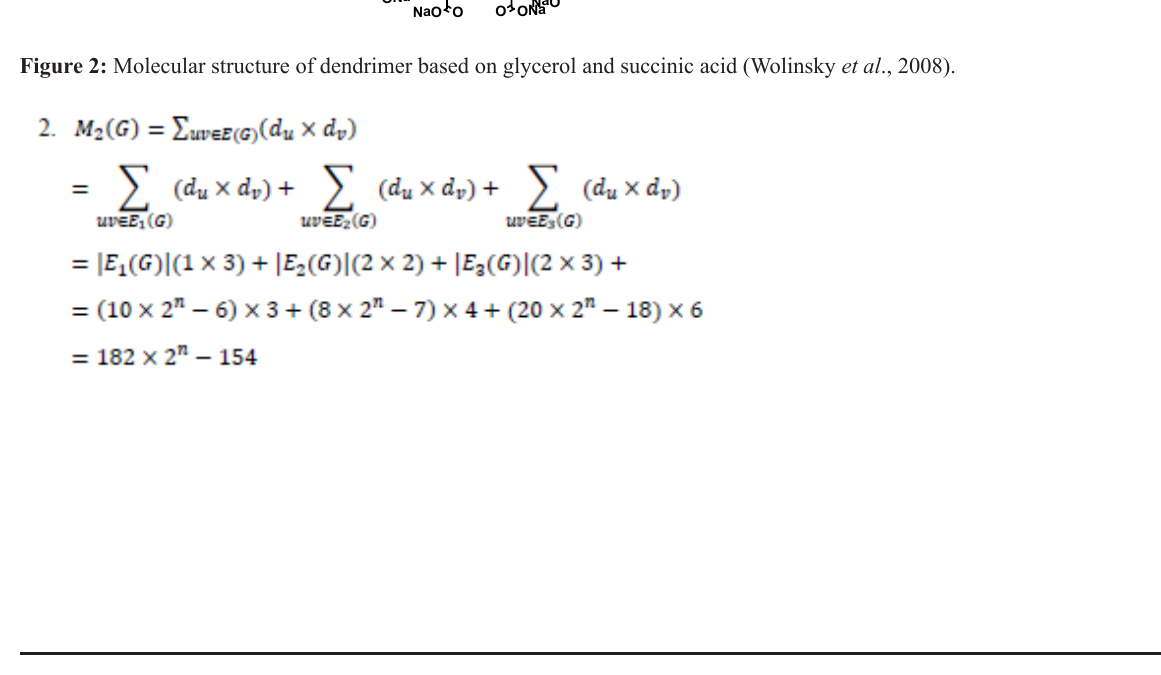
ONaO OO ONa OO OONa ONaO OO ONa OO ONaO OO OO ONaO OO O ONa O O O ONaO OO ONa O ONa O NaO O OO O O OO O O O O O O OO O OO O O ONaO O OO O OO O O O OONa ONaO O O O O OO OO O NaO O O OO O OO O O O OO O O O OO O O OO ONaO O O ONa O O O OONa O OO O O O ONa O OO O O OO O O OO O O O O ONaO O O O ONaO O OOO O O O ONaO OO OO O OO ONa OO O O OO OO O O O O O O OO O OO OOO O O OO OO OO ONaO O O O O NaO O OO OOO O ONaO OOOO O O OO OO O OO O O O ONa O O O OO O ONaO O O O O O O NaO O O OO NaO NaO O O ONaO O O O O O ONaO O O O ONaO OO OO O O OO OO O O ONaO O OO ONaO O O O O O OO OO O O OO O O O O OO O O NaO O O O O ONaO O O O O O OO O O O O O O O NaO O OO OO OOOO O NaO O ONaO O O O O O O OOO O O O O OOOO OO NaO O O OO ONaO O O O O O ONaO O OO ONaO NaOO OO NaO ONaO O OO O NaO